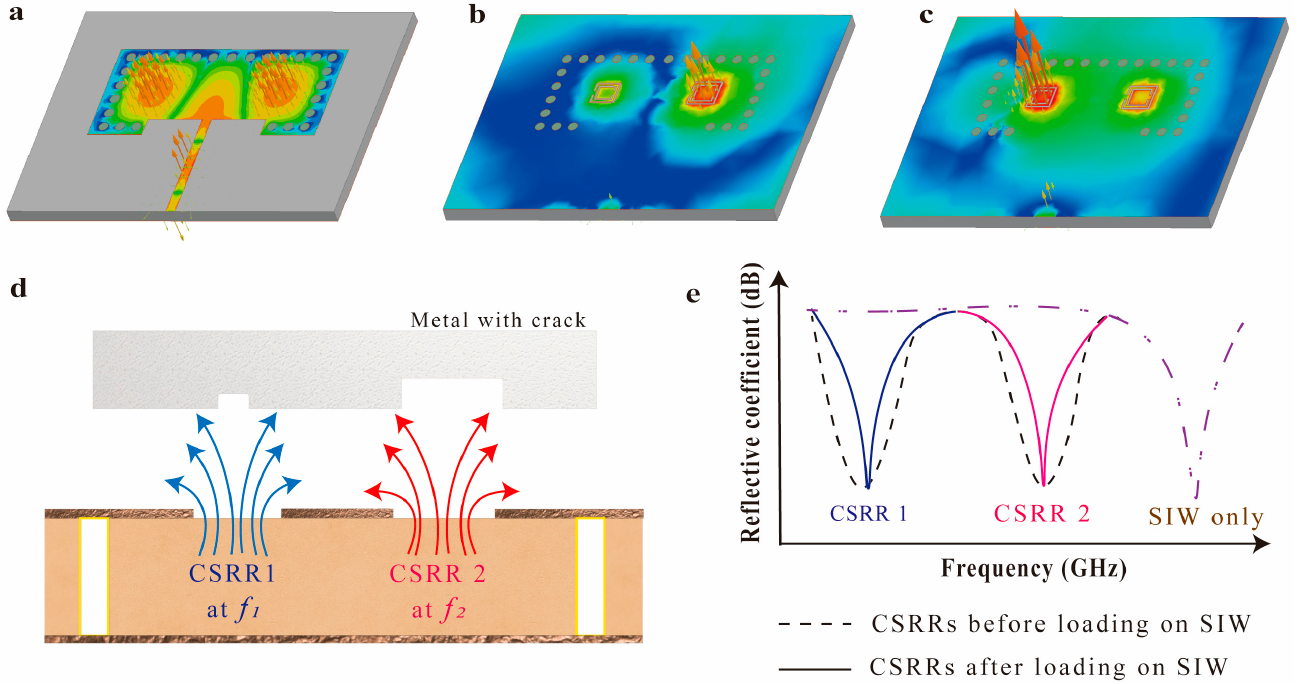
Figure 1. Proposed multi-crack detecting sensor with a high Q-factor: ( a ) TE 20 mode SIW only E-field vector distribution. E-field vector distribution after the integration of the CSRRs ( b ) at 4.69 GHz and ( c ) 5.49 GHz. The E-field intensity range of ( a – c ) is the same. Concept illustration of ( d ) independent multi-crack detection and ( e ) the reflective coefficients before and after CSRR loading.